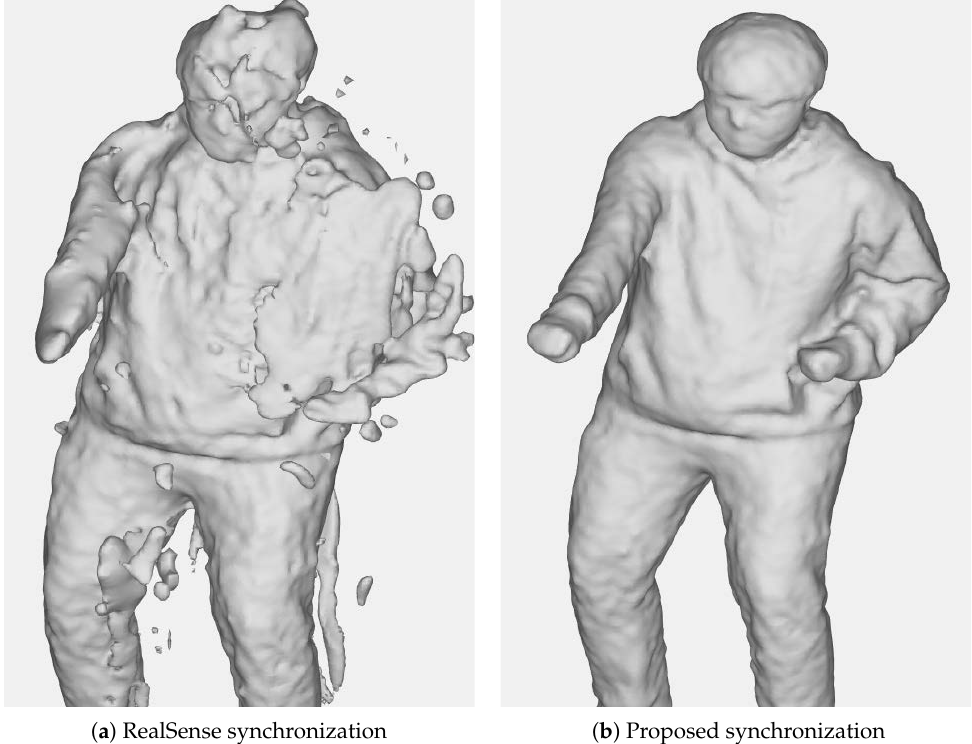
Figure 1. The reconstructions generated by a method in [9] using the data captured by 18 RGB-D cameras with ( a ) the Slave/Full Slave synchronization mode and ( b ) the proposed synchronization method,